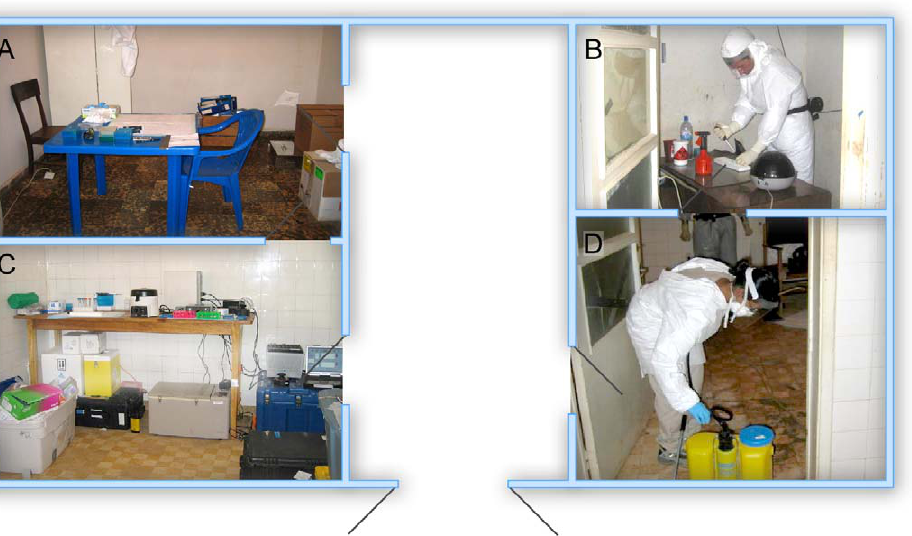
Figure 1. Laboratory set up and procedures. Laboratory space was made available to us in the Paediatric Ward of the Uige Provincial Hospital. Four rooms were used for the laboratory set up to ensure isolation of infectious work from other activities and to separate PCR assay steps to minimize contamination. (A) Room for RT-PCR master mix preparation; (B) room for sample inactivation; (C) room for RNA extraction and real-time RT- PCR; (D) room for PPE donning and